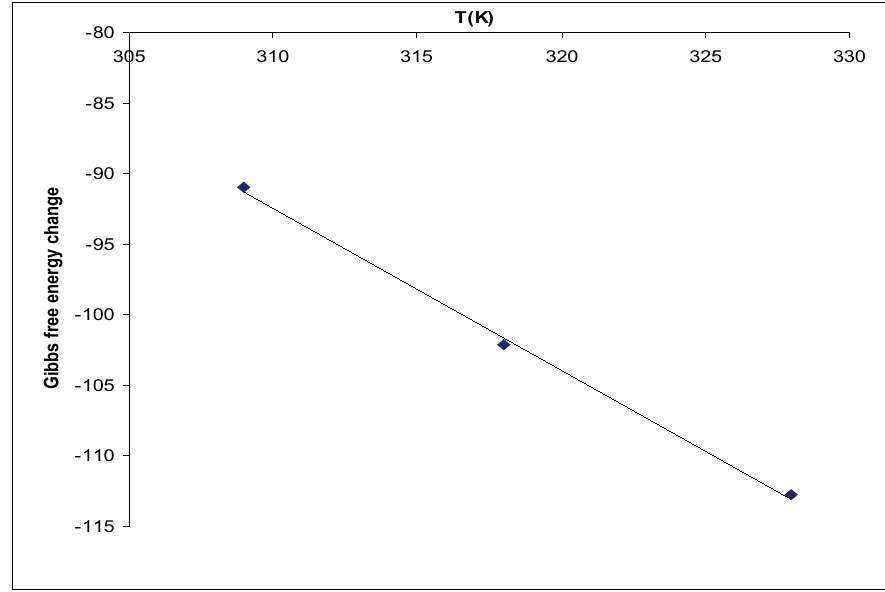
Figure 6. Relationship between Gibbs free energy change ( Δ G 0 ) and temperature for the sorption of CR by